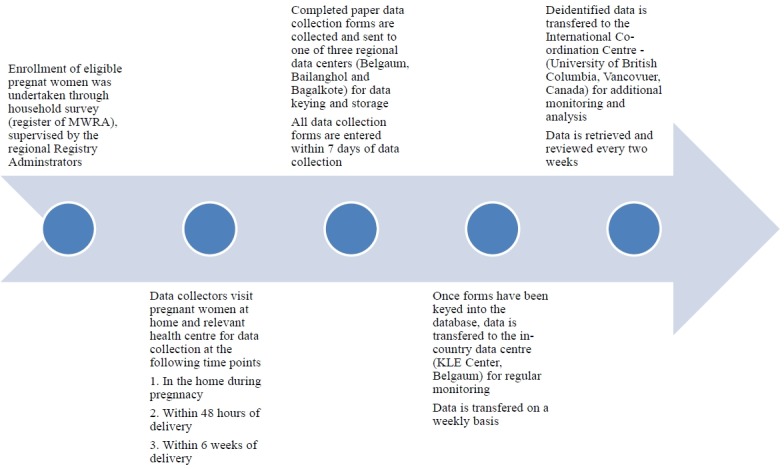
Data flow process.